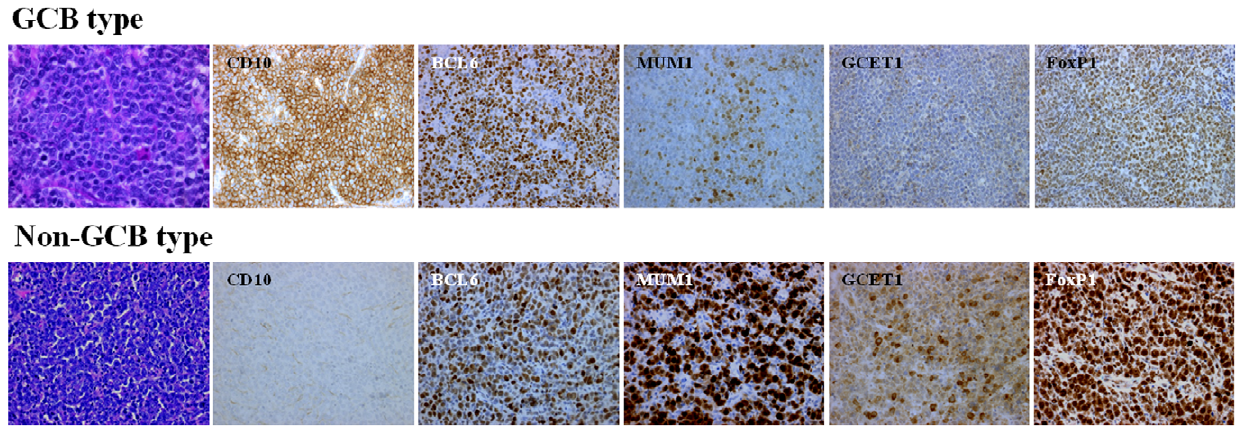
Figure 1. Histological and immunohistochemical features. Diffuse infiltration and proliferation of large lymphoma cells (Hematoxylin–eosin staining).